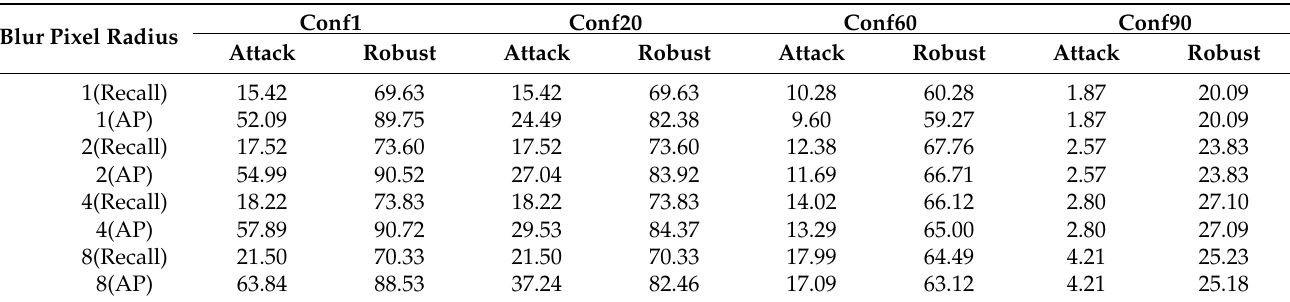
Table 5. Model defense performance after processing adversarial patch with different Gaussian blur radii. Attack means that the defense algorithm is not used, and Robust means that the defense algorithm is